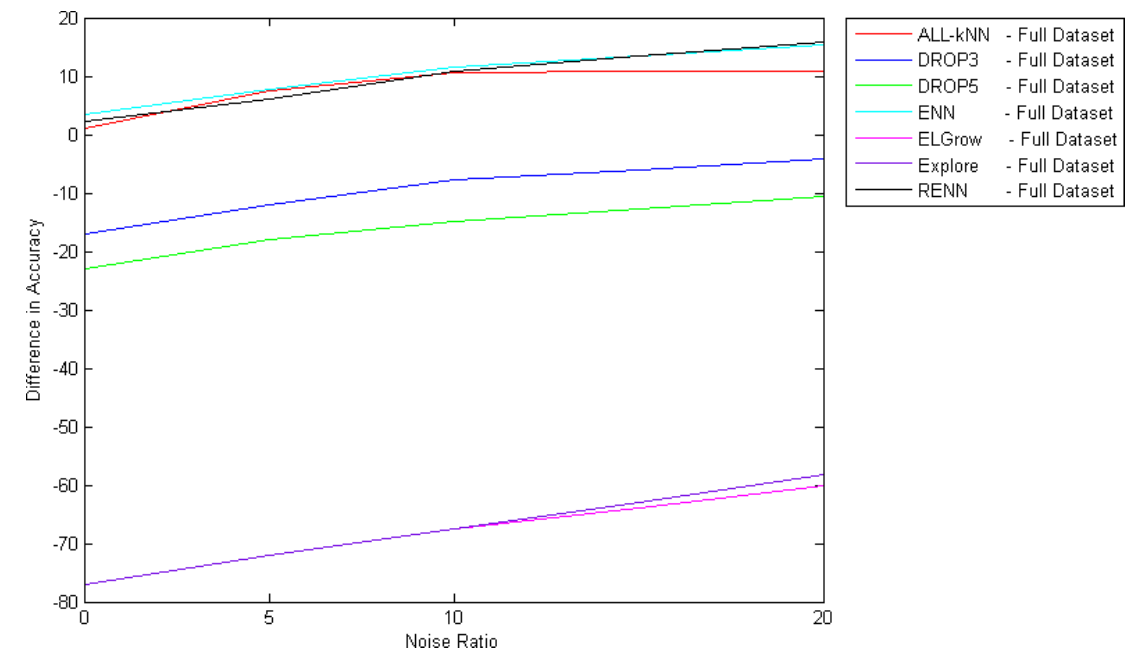
Figure 8: The Difference in accuracy between the full datasets and the reduced datasets without